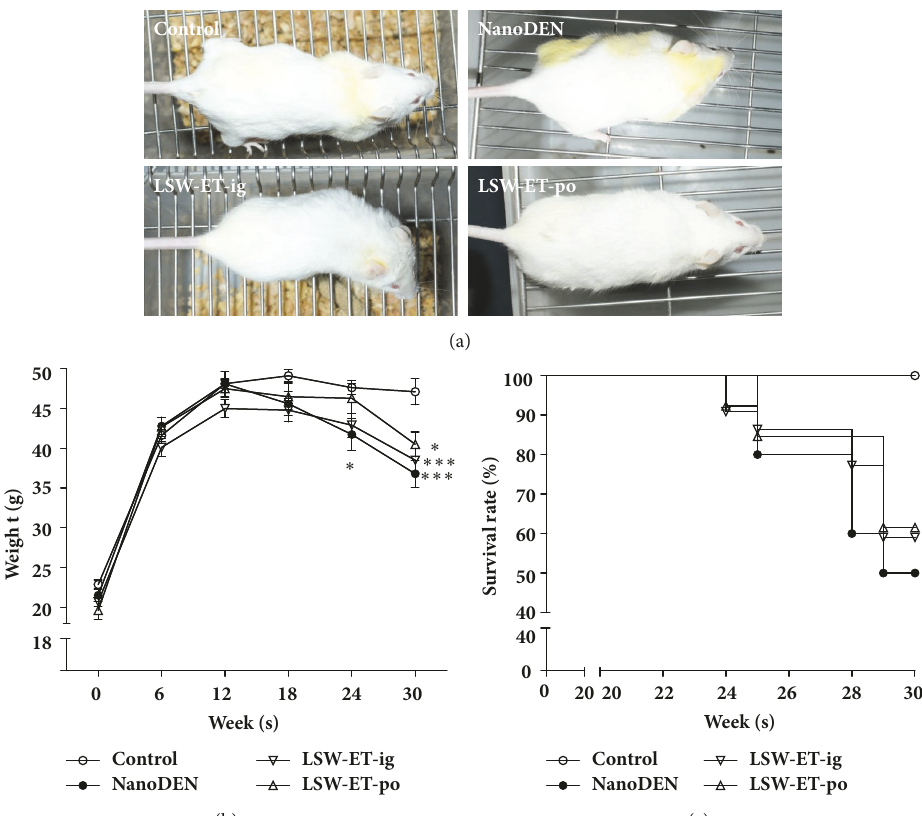
Figure 2: The overviews of mice with different treatments. (a) General view of the mice. (b) Gain of body weight in different groups during the experiment. (c) Survival rates of mice in various groups during the liver carcinogenesis. ∗ and ∗ ∗ ∗ , P < 0.05 and 0.001, respectively; † , P > 0.01 compared with the control group; ‡ , P > 0.01 compared with the nanoDEN group.